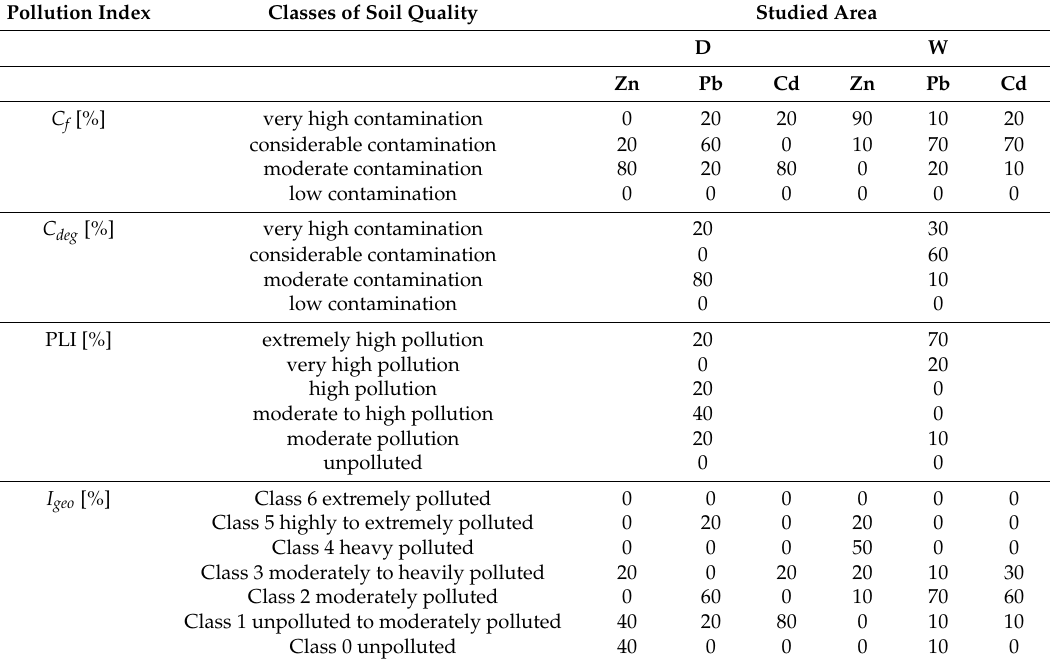
Table 5. Percentage of class distribution of topsoil pollution for indices considered. D—Dlugoszyn area, W—Wilkoszyn